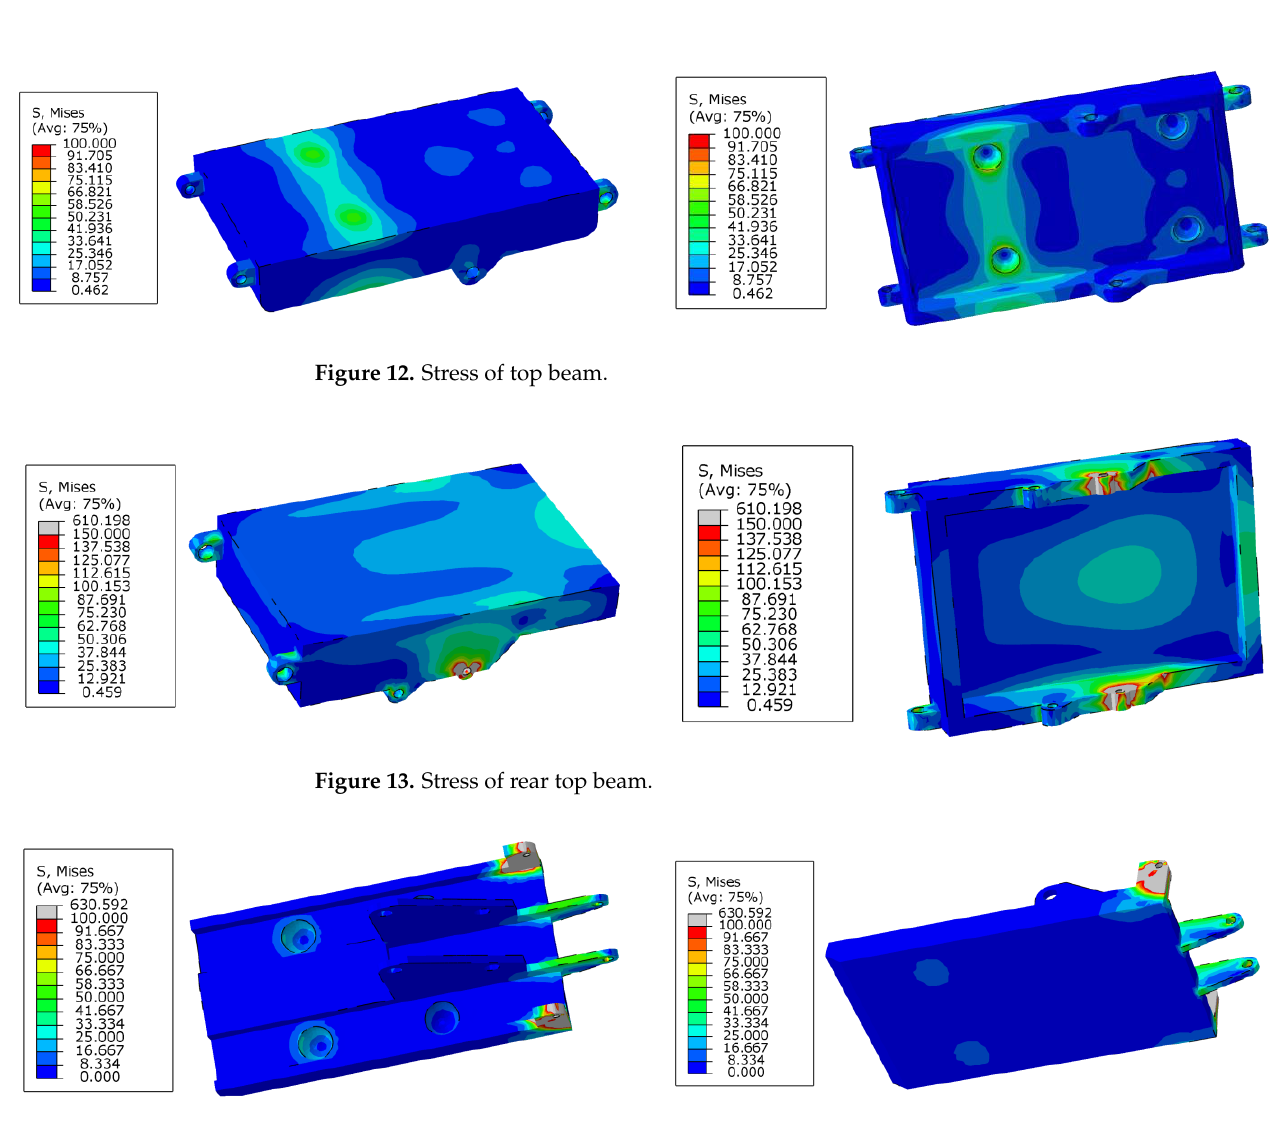
Figure 14. Stress of base.